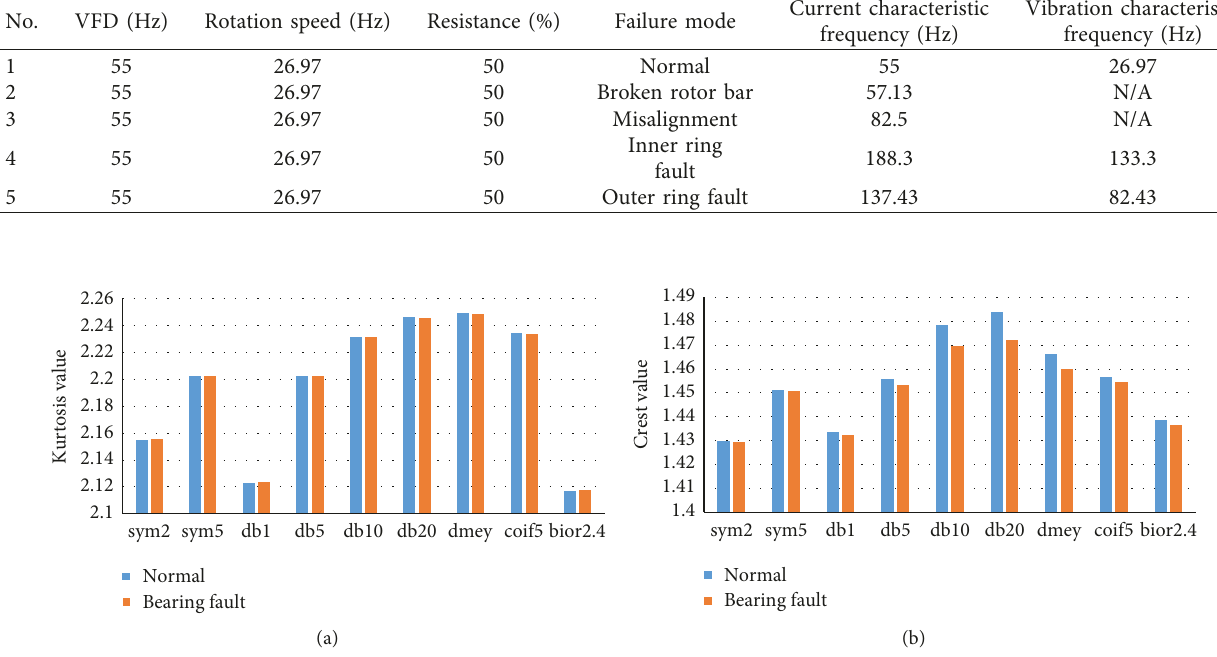
Figure 7: (a) Kurtosis factor and (b) crest factor of the vibration signal.